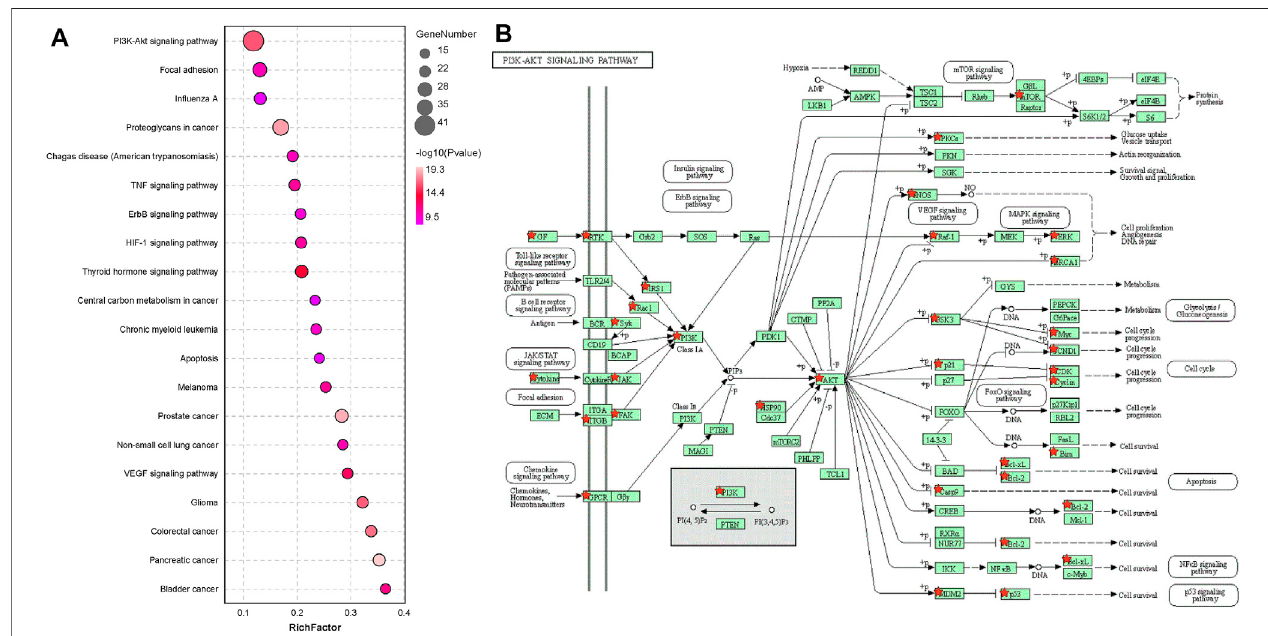
FIGURE 2 | AKT1 is a signi fi cantly correlated target. (A) KEGG pathway analysis of 179 targets (Top 20 targets of KEGG enrichment). (B) KEGG pathway analysis of the PI3K/AKT